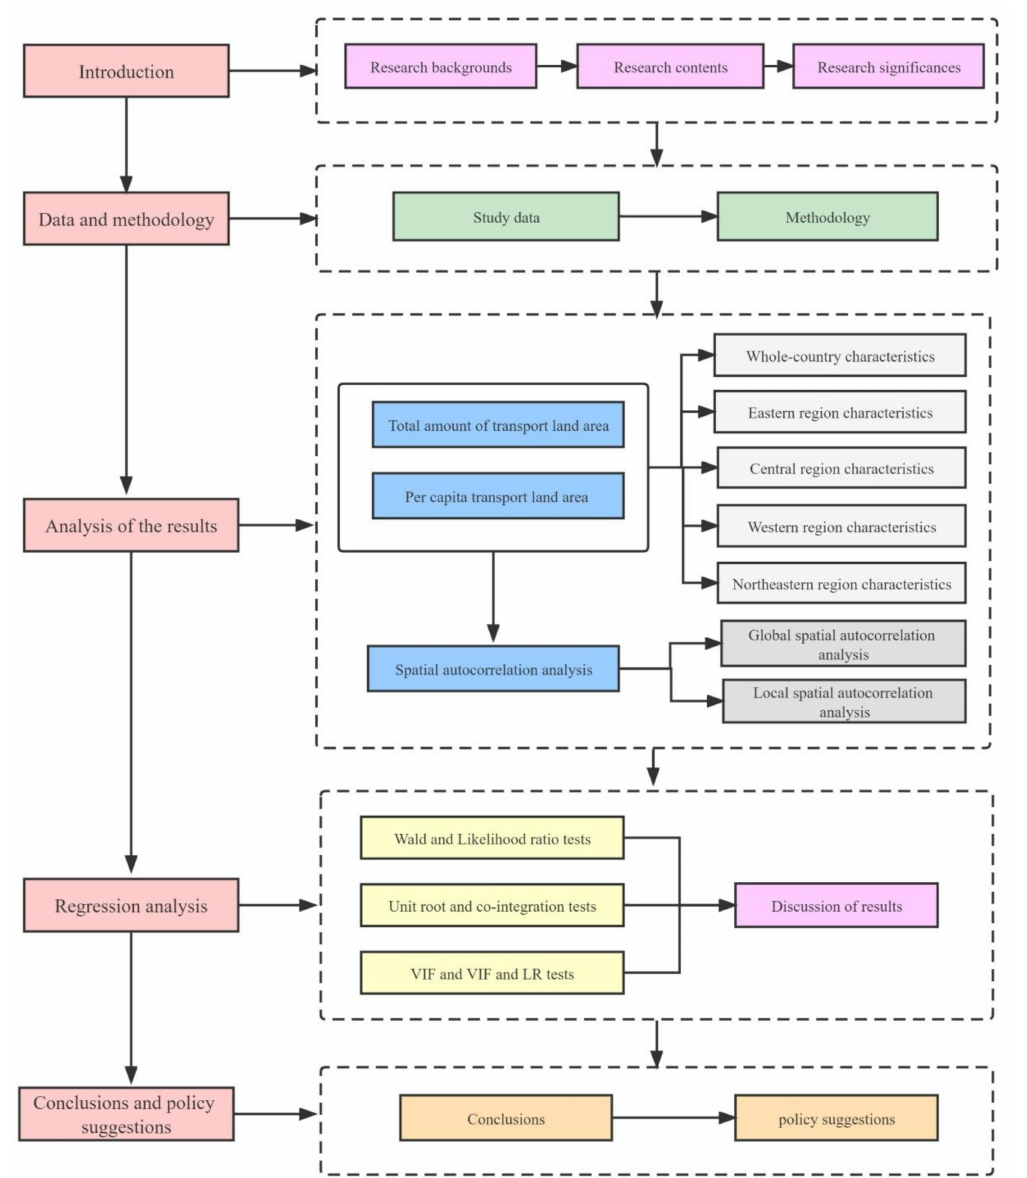
Figure 1. Flowchart of the present